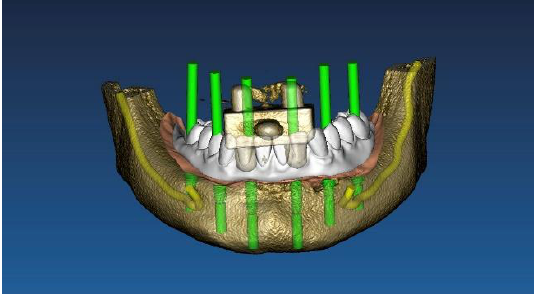
Figure 1. Virtual implant planning of four implants according to the All-on-4 protocol.